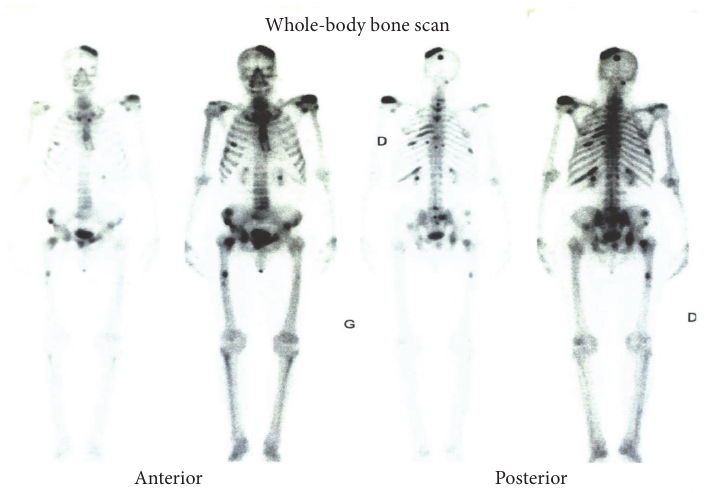
Figure 2: Bone scintigraphy showing metastatic lesions on the left parietal bone, left humeral head, and the spines.